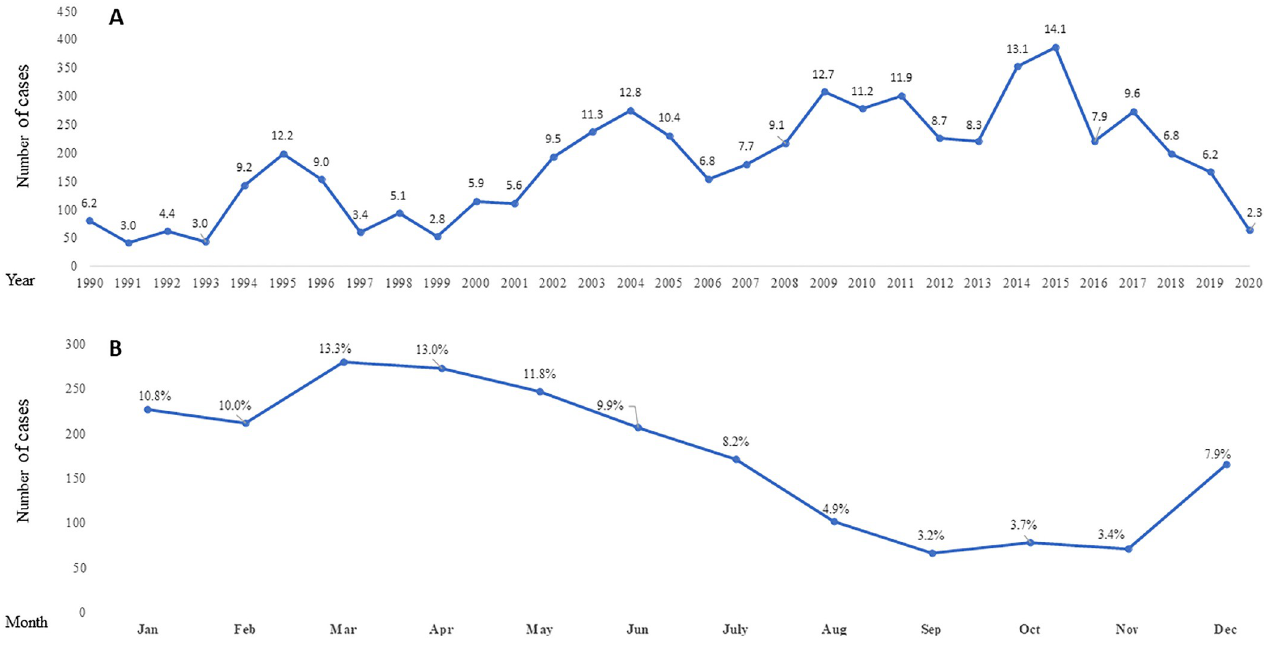
Fig 2. Annual and seasonal distribution of human cutaneous leishmaniasis in Palestine between 1990–2020. (A) : Annual distribution of cutaneous leishmaniasis patients 1990–2020. Data labels show annual incidence rate per100.000 population calculated for each year (B): Seasonal distribution of patients per month represented by the date of reporting as obtained from PMoH profiles. Data labels show percentage of cases per month over the studied period.